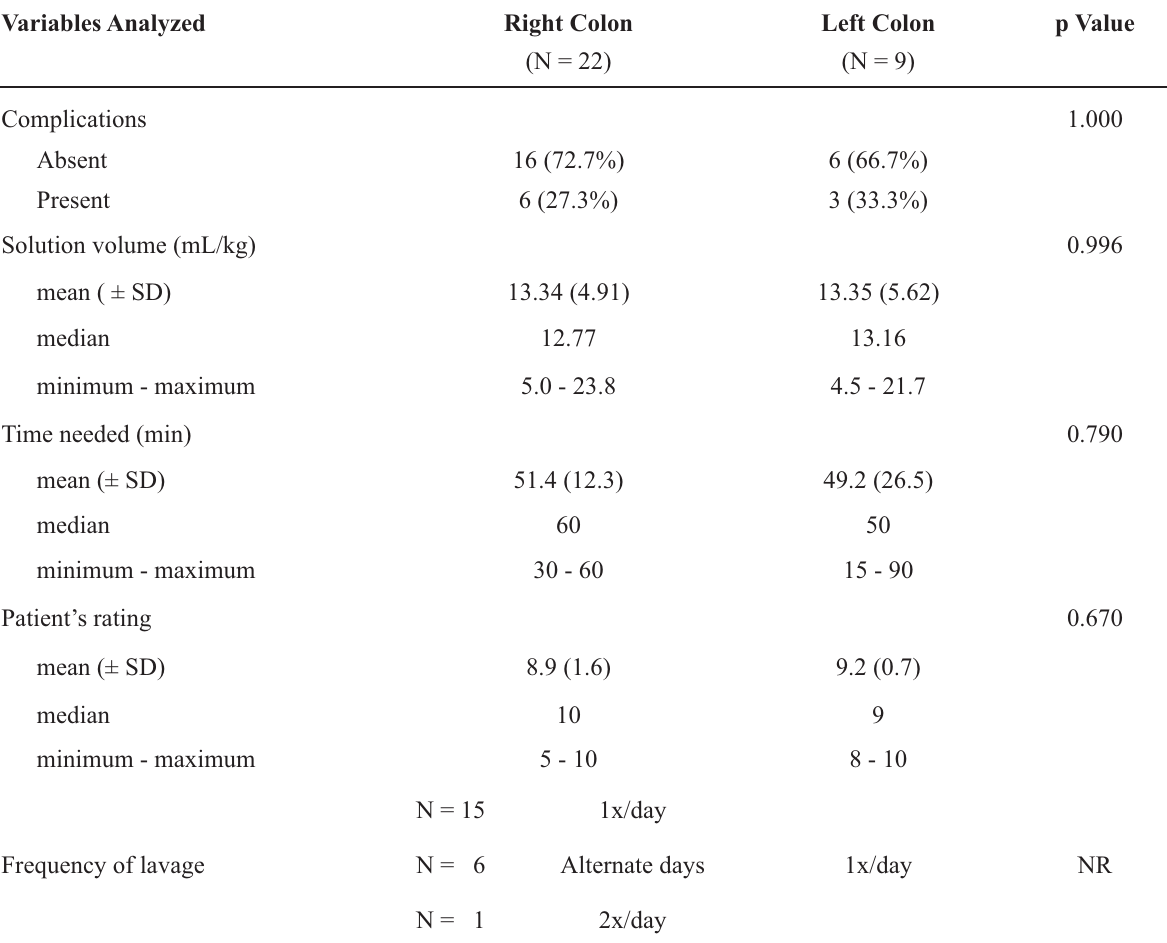
Table 3 – Left colon versus right colon. Variables